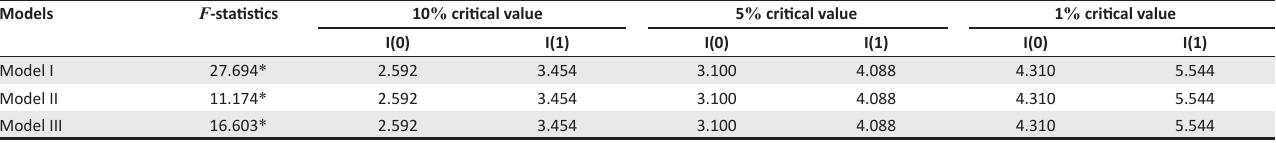
TABLE 6: Non-linear autoregressive distributive lag bound test cointegration results. Models